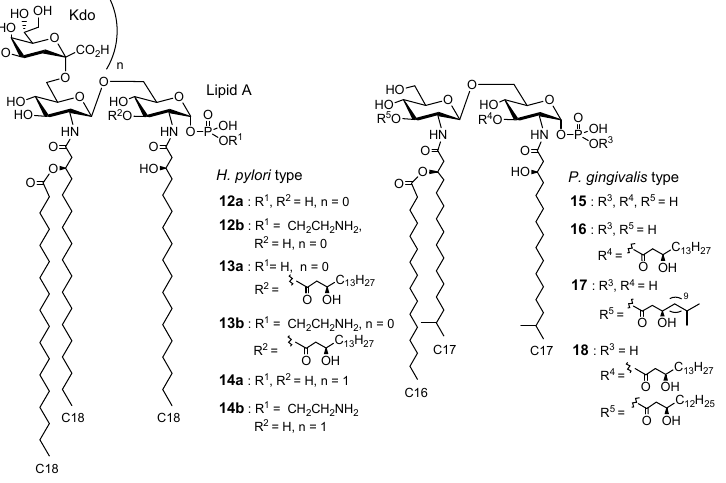
Figure 7. Chemical structures of parasitic bacterial lipid As. Canonical E. coli lipid A ( 1 ) (Figure 2) consists of six fatty chains (C12–C14), whereas H. pylori lipid A 12 , 13 has fewer (three to four) but longer (C16–C18) fatty chains. As for the phosphate groups, the canonical E. coli lipid A ( 1 ) has two phosphate groups